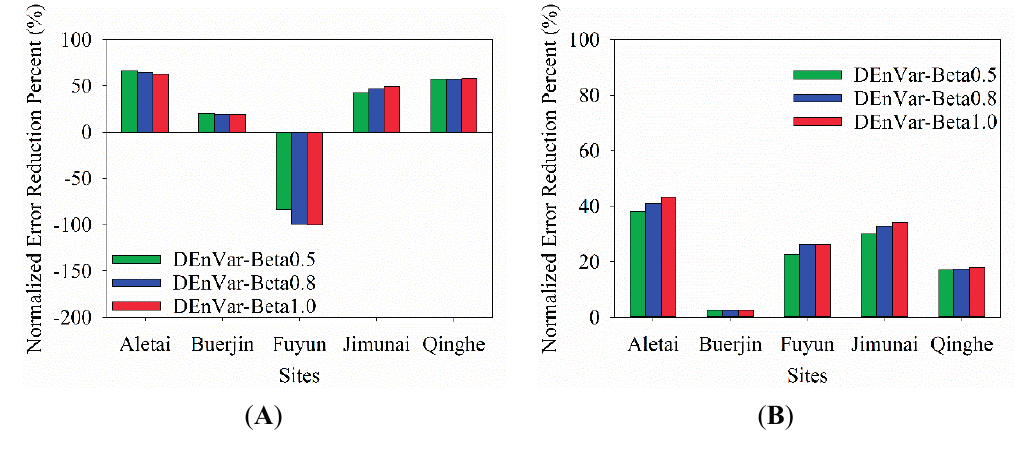
Figure 8. The NEPR of the analyzed SD ( A ) and SWE ( B ) in the DEnVar-Beta 0.5, DEnVar-Beta 0.8, and DEnVar-Beta 1.0 sensitivity